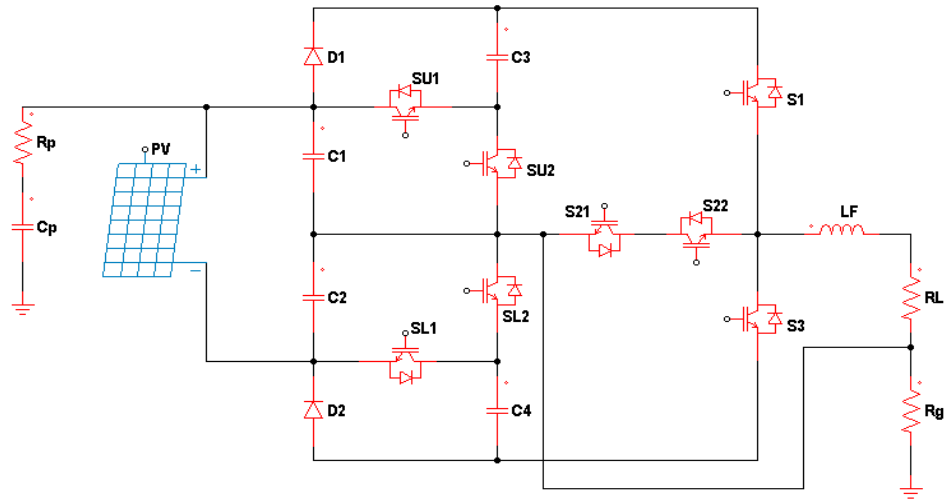
Figure 8. A five-level inverter with eight switches.